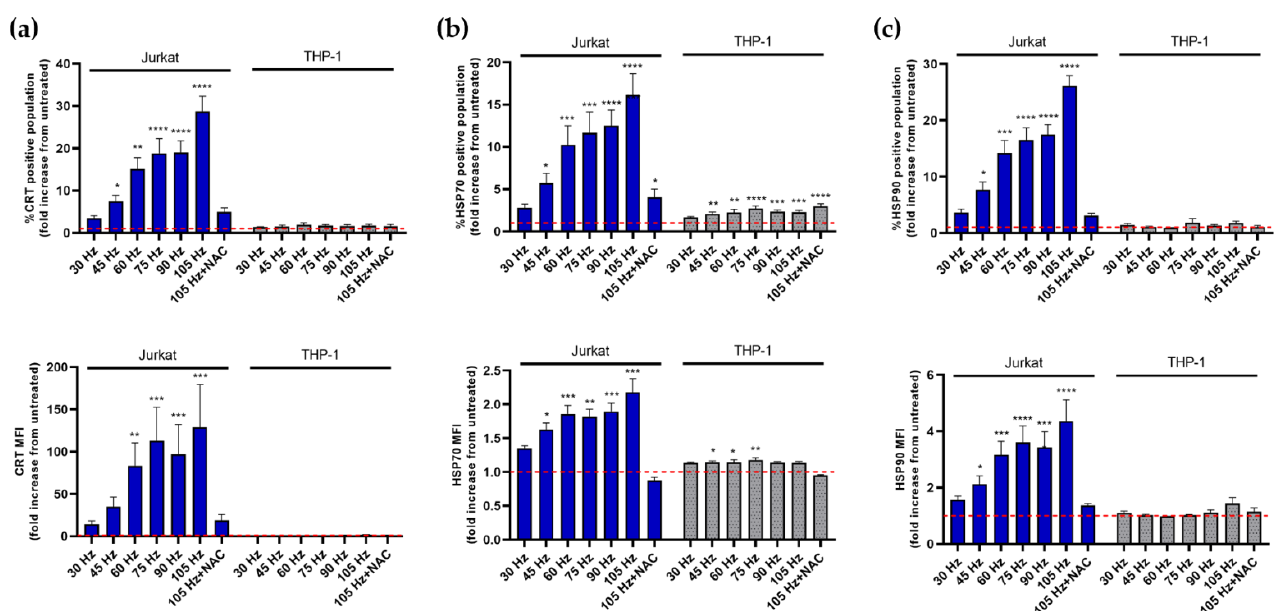
Figure 4. Jurkat and THP-1 cells display pro-phagocytic DAMPs following NTP exposure. The magnitude of increased surface display of ( a ) CRT, ( b ) HSP70, and ( c ) HSP90 differs between NTP-exposed Jurkat and THP-1 cells 24 h post-exposure. Dotted line indicates no change with respect to cells in the absence of NTP. Data are presented as mean ± SEM. Significance was calculated using a Kruskal–Wallis test with Dunnett’s post-hoc test (* p < 0.05, ** p < 0.01, *** p < 0.001, **** p < 0.0001).